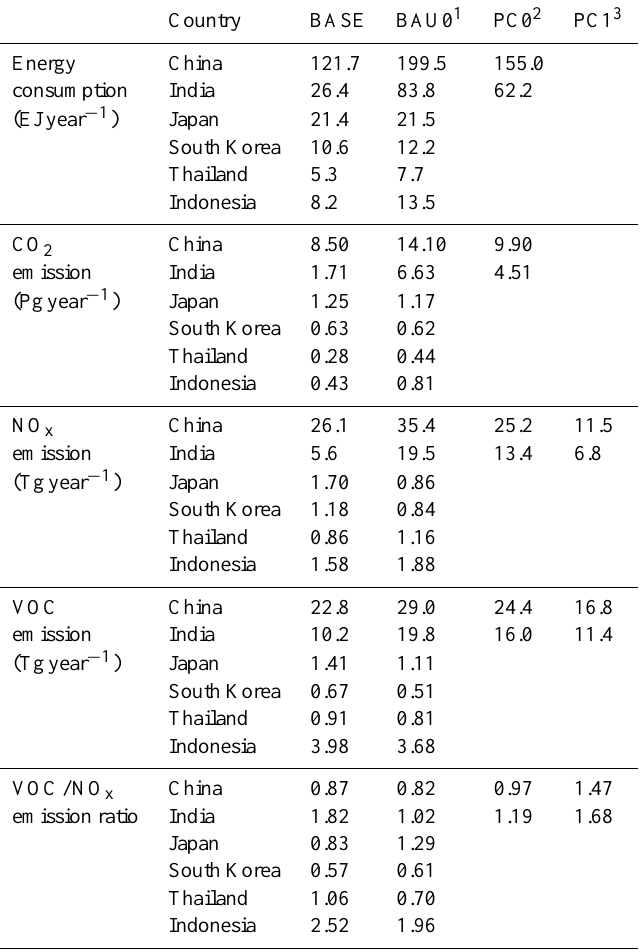
Table 1. Annual energy consumption and CO 2 , NO x , and VOC emissions estimated for 2010 (BASE) and 2030 under three future scenarios. VOC/NO x emission ratios are also